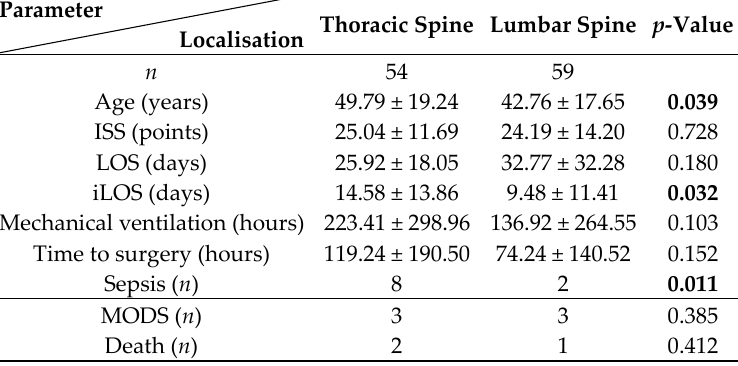
Table 10. Stratification analysis (ANOVA and chi-square test) of the fracture localisation.